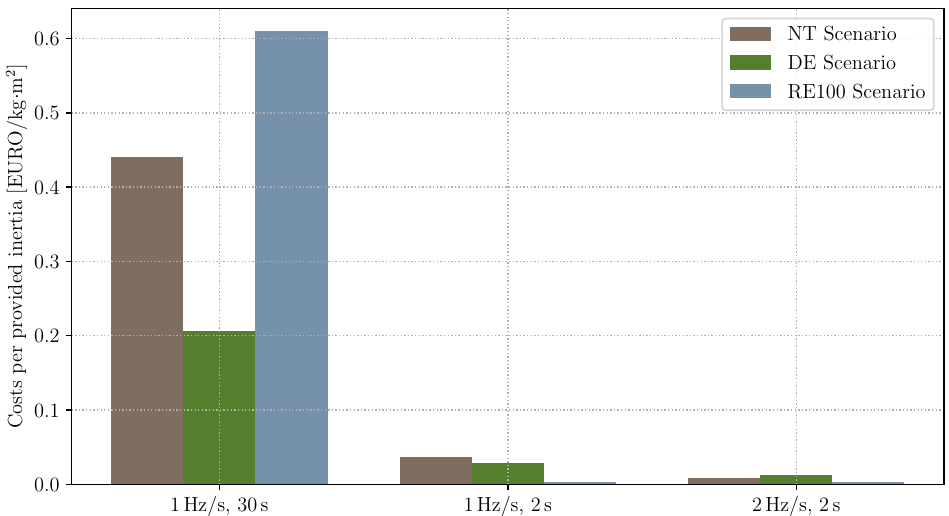
Figure 8. Illustration of additional system costs with respect to the additionally provided inertia due to the integration of inertia constraints into the dispatch model. The costs are indicated in EURO per provided inertia in kg m 2 ·